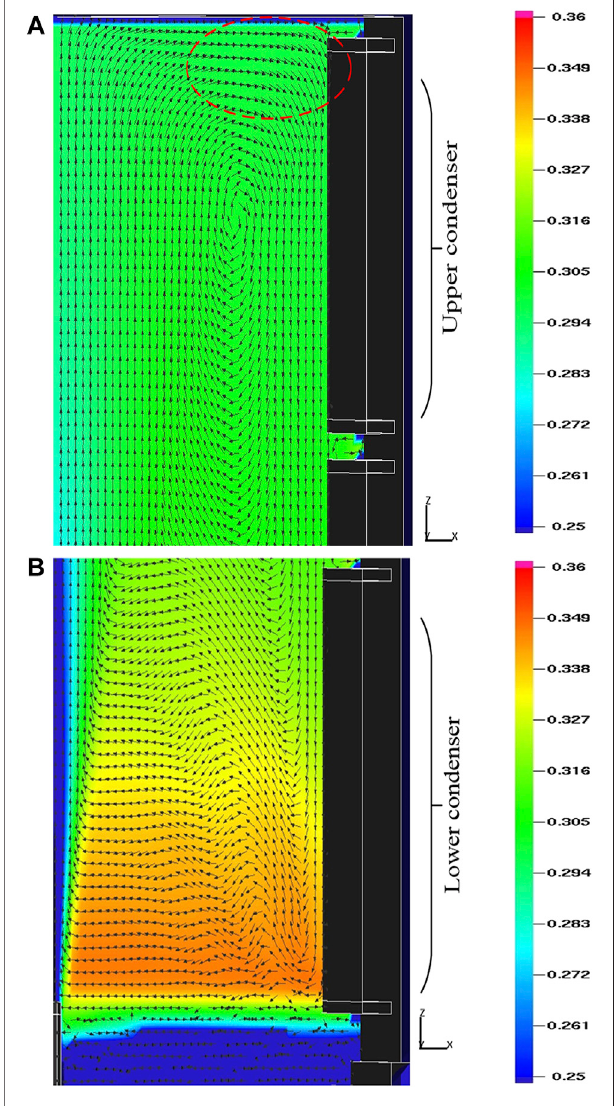
FIGURE 12 | Flow fi eld distribution and helium volume fraciton distribution(PhaseB,t (cid:1) 9000 s). (A) Uppercondenser. (B)